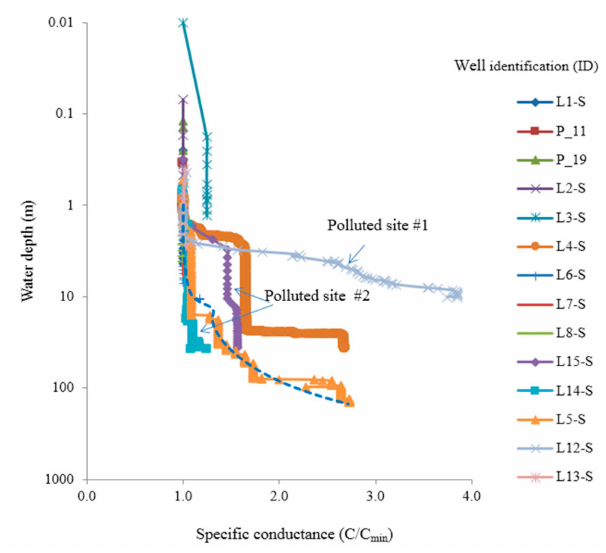
Figure 7. Relative specific conductance vs. water depth in 14 boreholes of the Bari aquifer positioned at different distance from Ghyben-Herzberg freshwater/sweater (50%) sharp interface position (Winter 2012) and best-fit equation (dashed